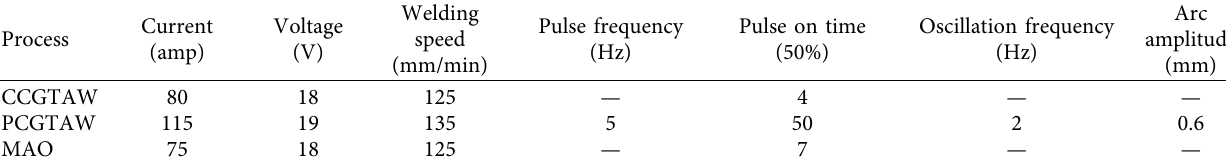
Table 3: Process